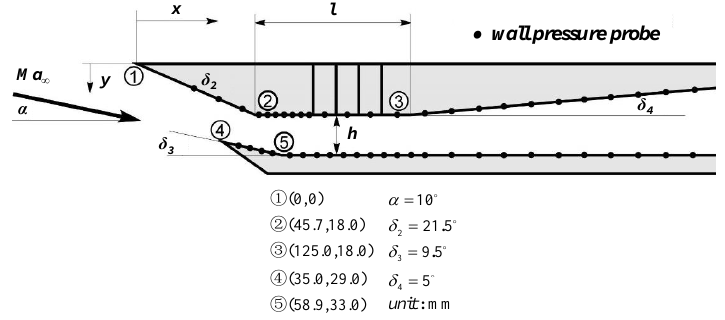
Figure 3. Configuration of the inlet/isolator: h = 15 mm, l = 79.3 mm.